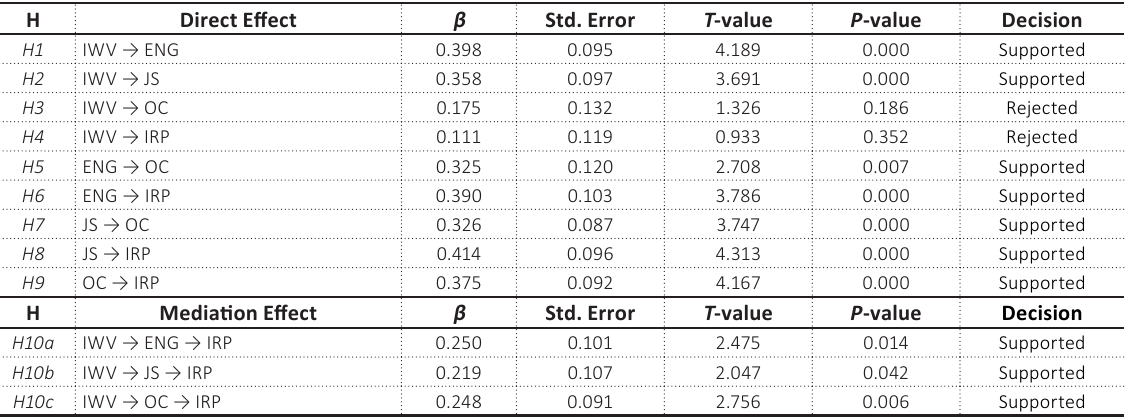
Table 5. Hypotheses